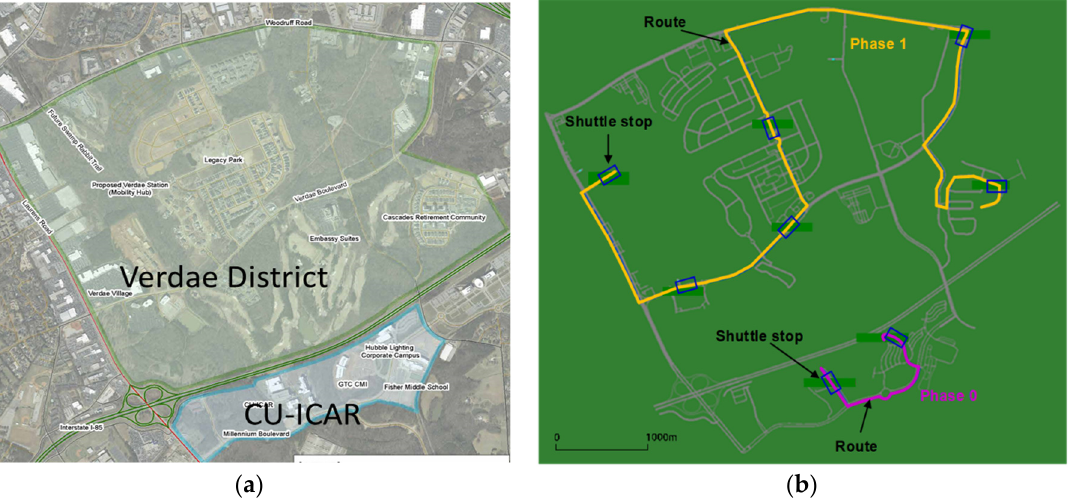
Figure 3. A-Taxi test field phase 0 (CU-ICAR) and phase 1 (Verdae District) at Greenville, SC: ( a ) satellite image; and ( b ) AMD simulation network and fixed-route configuration.